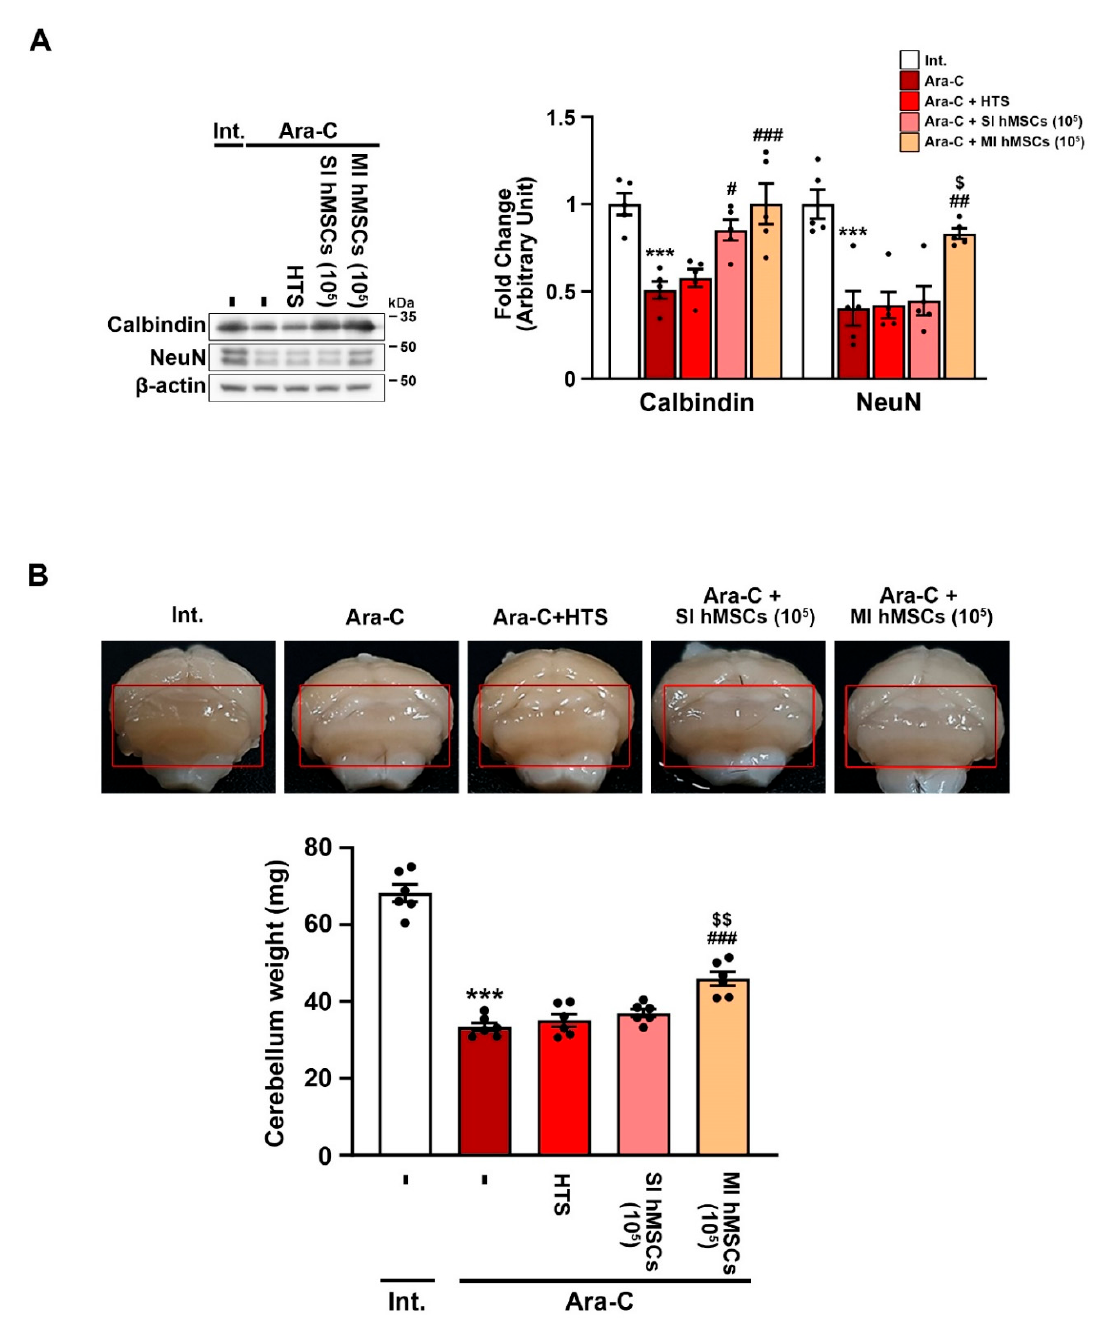
Figure 2. Treatment with hMSCs protects neurons in the cerebellum of Ara-C-induced CA mice. ( A ) Western blot analysis of calbindin (Purkinje cell marker) and NeuN (granule cell marker) in the cerebellum at 12 weeks after hMSC treatment. *** p < 0.001 vs. intact mice; # p < 0.05, ## p < 0.01, ### p < 0.001 vs. Ara-C-induced CA mice; $ p < 0.05 vs. single hMSC treatment in Ara-C-induced CA mice (one-way analysis of variance [ANOVA] with Tukey’s post hoc analysis; n = 5 for each group). ( B ) The measurement of cerebellum weight at 12 weeks after hMSC treatment. *** p < 0.001 vs. intact mice; ### p < 0.001 vs. Ara-C-induced CA mice; $$ p < 0.01 vs. single hMSC treatment in Ara-C-induced CA mice (one-way ANOVA with Tukey’s post hoc analysis; n = 6 for each group). Int., intact; Ara-C, cytosine arabinoside; HTS, hypothermosol; hMSCs, human mesenchymal stem cells; SI, single injection; MI, multiple injection; NeuN, neuronal